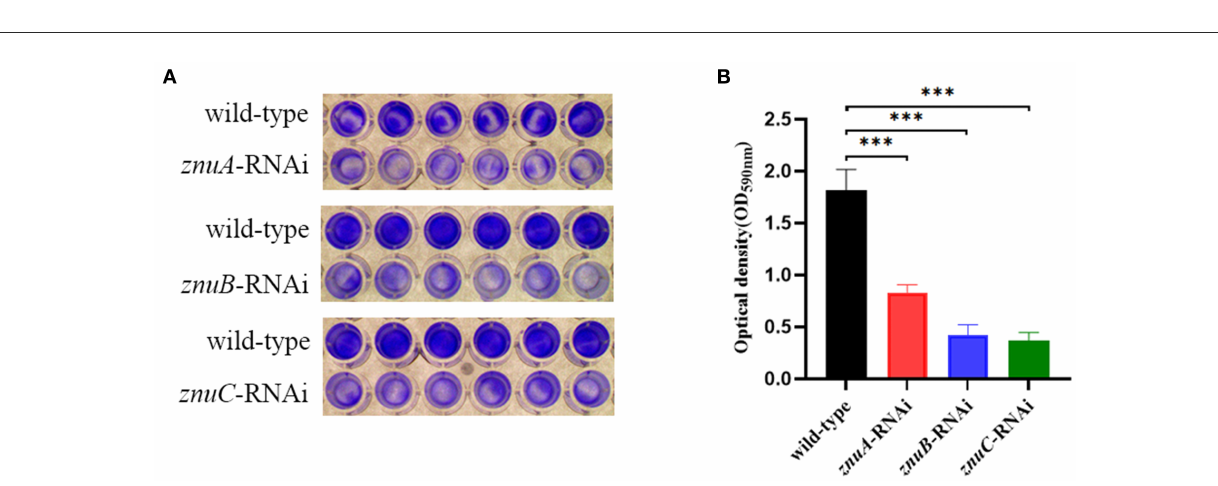
significantly more than that of znuA -RNAi, znuB -RNAi and znuC - RNAi, and indicated that the adhesion ability in vitro of znuA - RNAi, znuB -RNAi and znuC -RNAi were significantly lower than that of